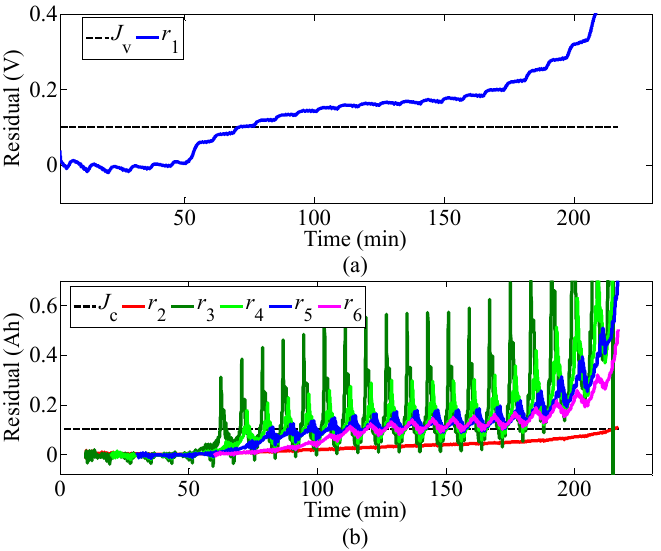
Figure 9. Residual responses for a current sensor fault: ( a ) r 1 ; ( b ) r 2 , r 3 , r 4 , r 5 , and r 6 . Since the voltage and current sensor faults are first detected through r 1 and r 3 shown in Figure 10, the sensor fault values can be calculated by Equations (19) and (22), respectively. For the voltage sensor fault, t a and t b are 56.3 min and 61.3 min, respectively, the average value of the voltage sensor fault U f is 0.247 V, and the fault error is 0.003 V. If t b is farther from t a , the fault value U f may be more accurate, but it will cause the later time to start 5 min as the fault value. Figure 11a shows the fault-tolerant control process of battery parameter identification. The battery static characteristic parameter OCV is automatically corrected to the reference value from 61.3 min based on the voltage fault value and the SOC difference caused by the fault.